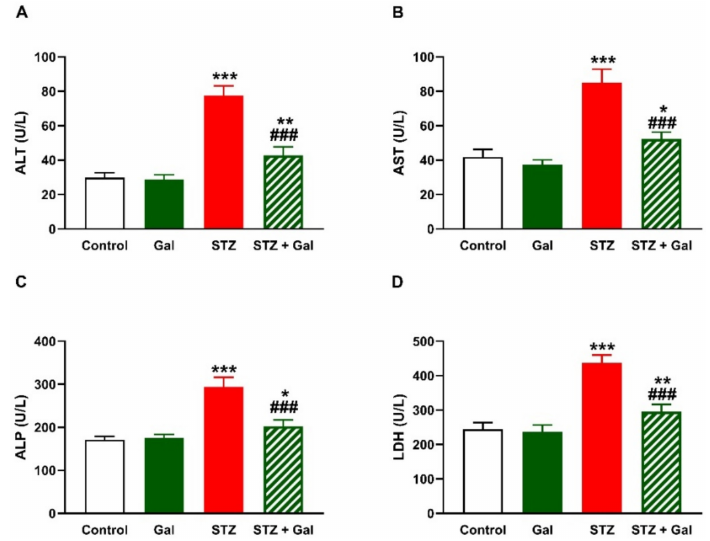
Figure 3. Galangin ameliorates circulating transaminases ALT ( A ), AST ( B )), ALP ( C ), and LDH ( D ) in diabetic rats. Data are mean ± SEM, n = 6. * p < 0.05, ** p < 0.01 and *** p < 0.001 versus control. ### p < 0.001 versus diabetic.